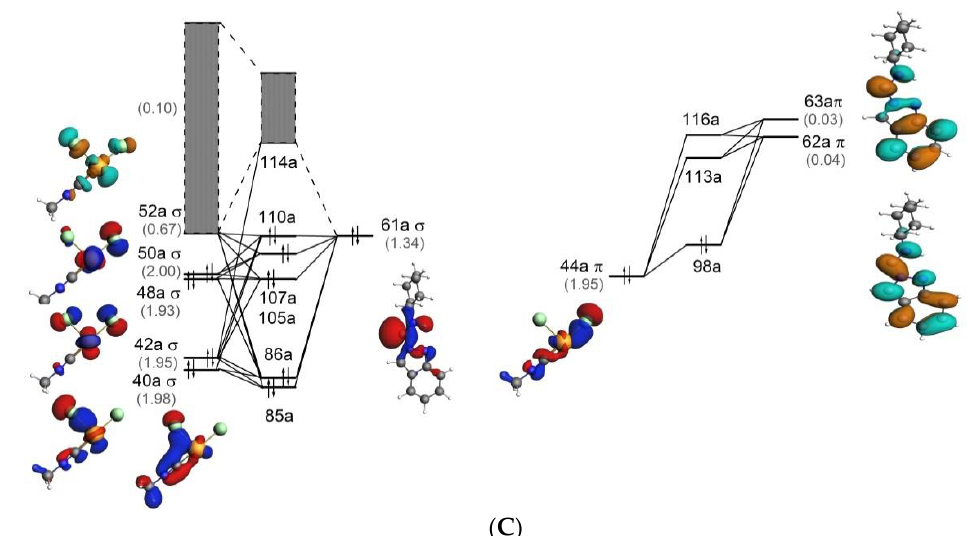
Figure 5. Molecular orbital diagrams for 1 ( A ), Z - P1 ( B ), and Z - P2 ( C ) for the Pd ← C ( σ type) (left) and Pd → C ( π type) (right) interactions. Corresponding orbitals populations (in e) are given in parentheses. Isosurface values are 0.05 e 1/2 /Å 3/2 . Gray bands indicate the overall participation of the virtual orbitals with populations other than 0.00.